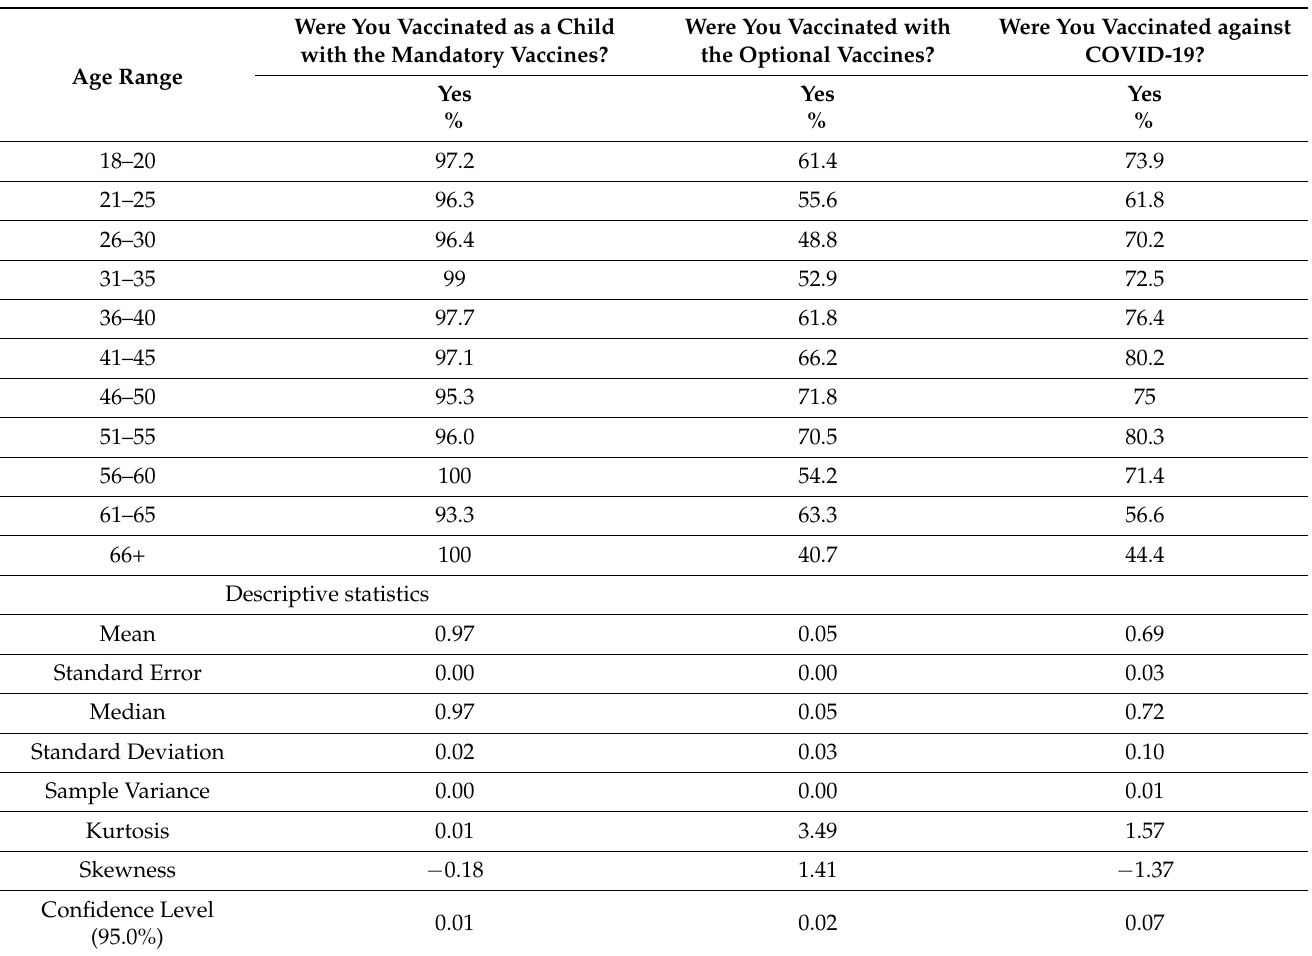
Table 3. The degree of vaccination of participants with mandatory, optional, and anti-COVID-19